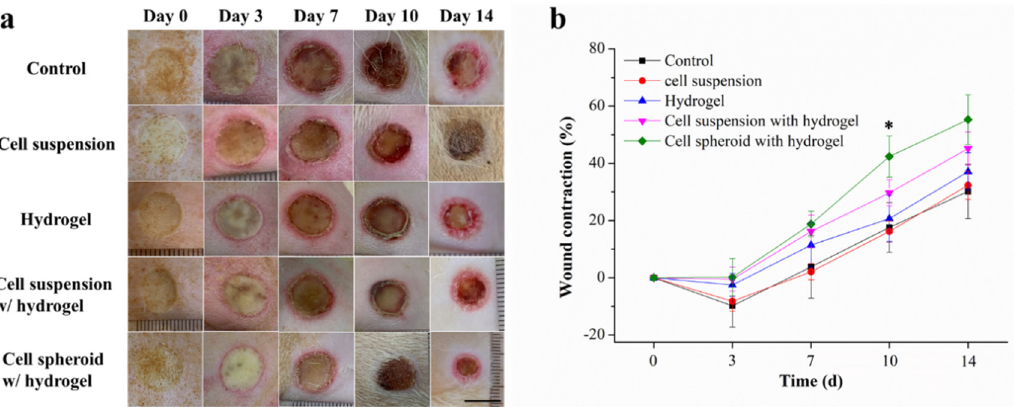
Figure 2. ( a ) Photographs of representative wounds and ( b ) wound contraction rates as a function of wound healing effect as estimated by ImageJ analysis of wound size (n = 4): samples were analyzed with one-way ANOVA, * p < 0.05. Error bars represent mean ± s.d.